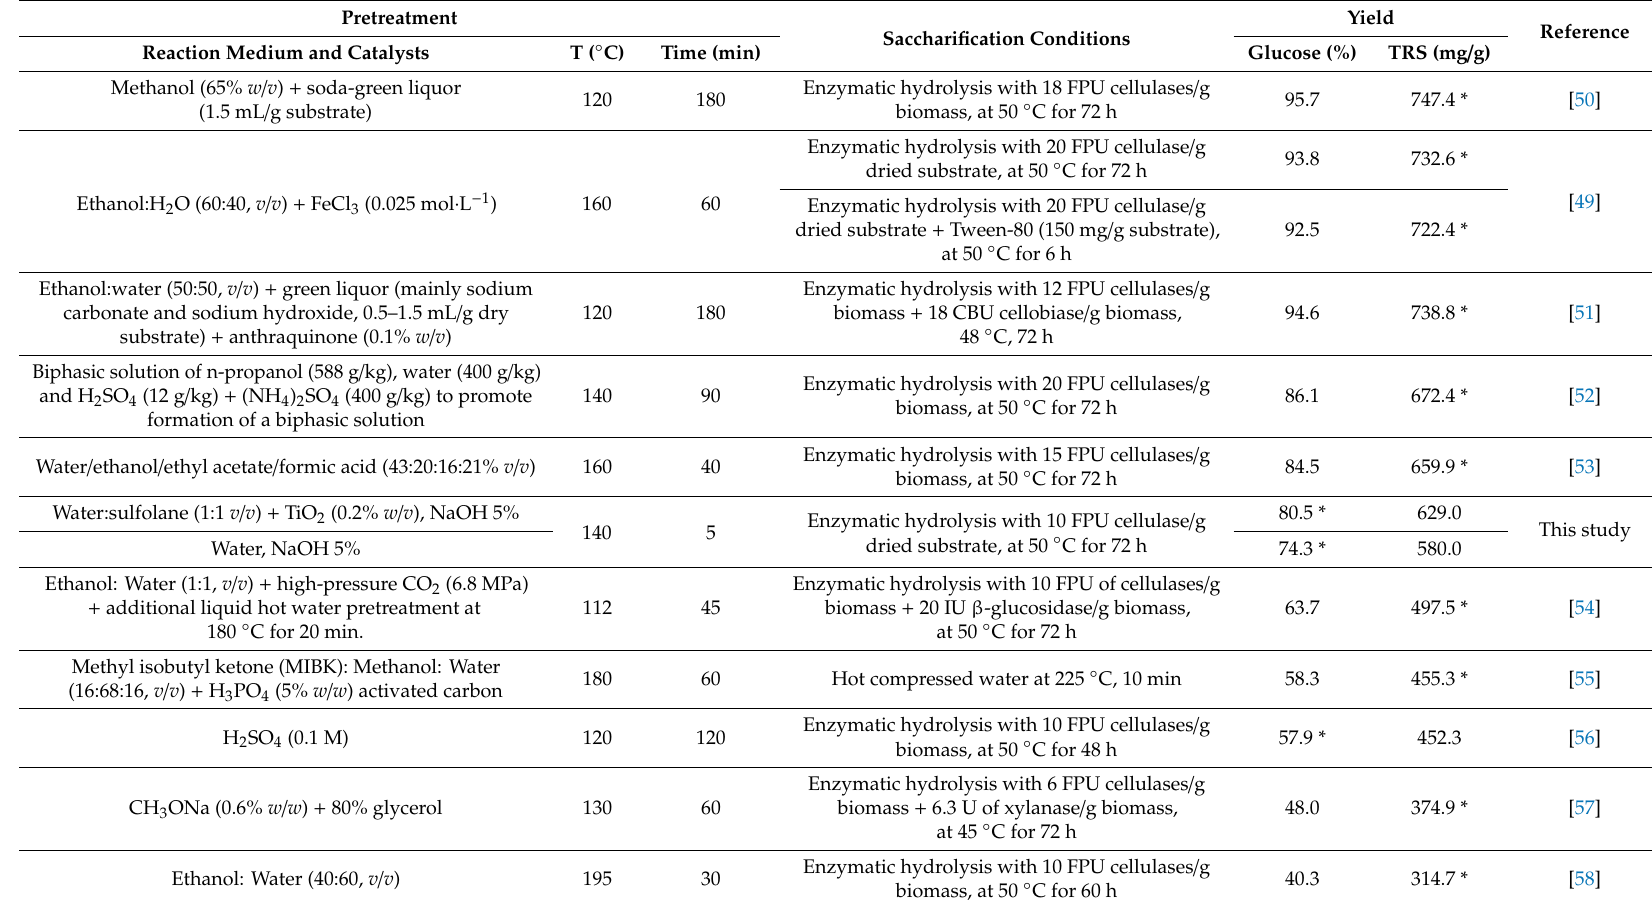
Table 7. Comparison of the yield results presented herein with the reported